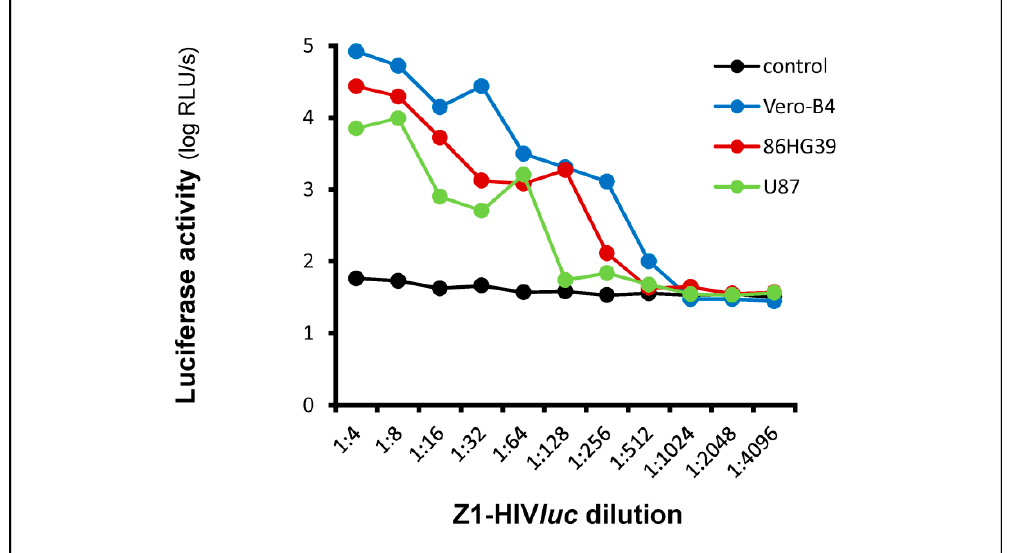
Figure 3. Luciferase activity in Z1-HIV luc infected cell lines. CCS containing Z1-HIV luc was tested for infection of Vero-B4, 86HG39, and U87 cells at various dilutions. CCS from pNL Luc AM transfected HEK293T cells was used as a negative control. All RLU/s data are means of quadruple infections using a CCS from one transfection. For all data points, the standard deviation of the means was ≤ 20% (controls ≤ 12%).